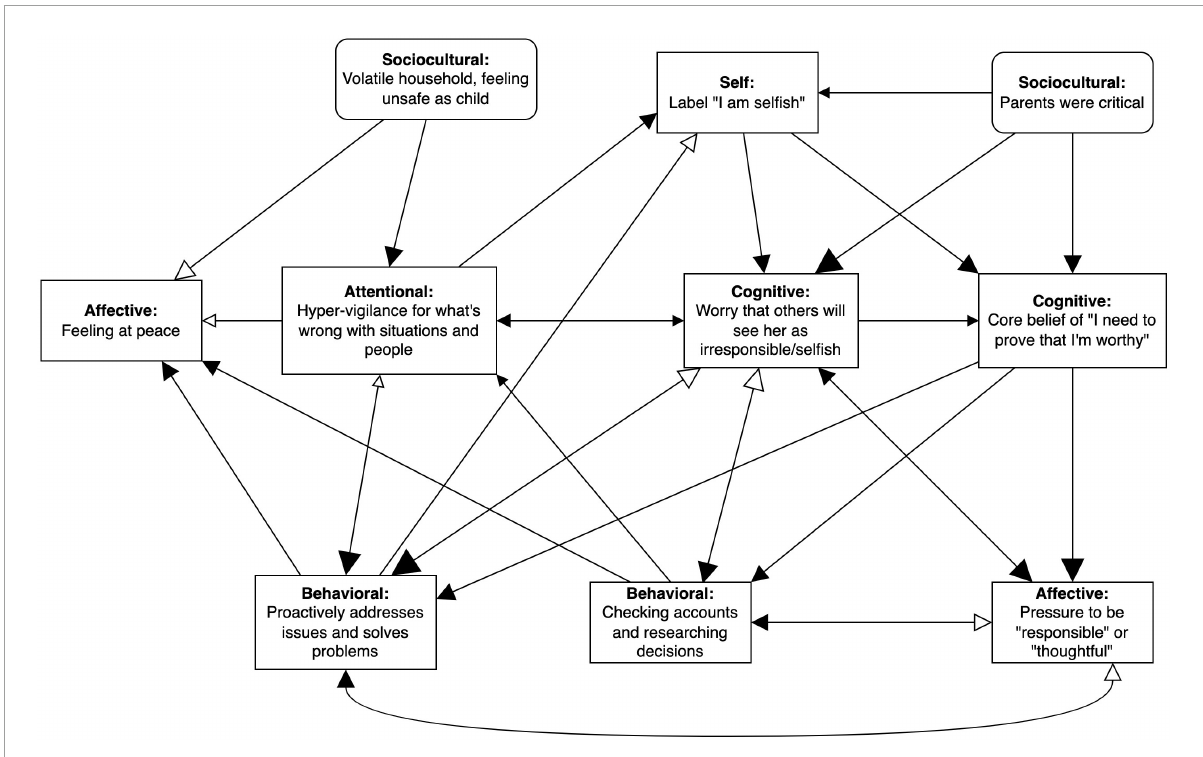
FIGURE2 Preliminary case conceptualization for Amy. EEMM dimensions represented by each node are bolded. Size of the arrowheads indicates hypothesized strength of the relationship (bigger arrowheads = stronger correlation), and opacity reflects direction of the relationship (opaque = positive/excitatory, transparent = negative/inhibitory). Right-angled rectangles reflect manipulable variables and rounded rectangles indicate immutable moderators (e.g., historical